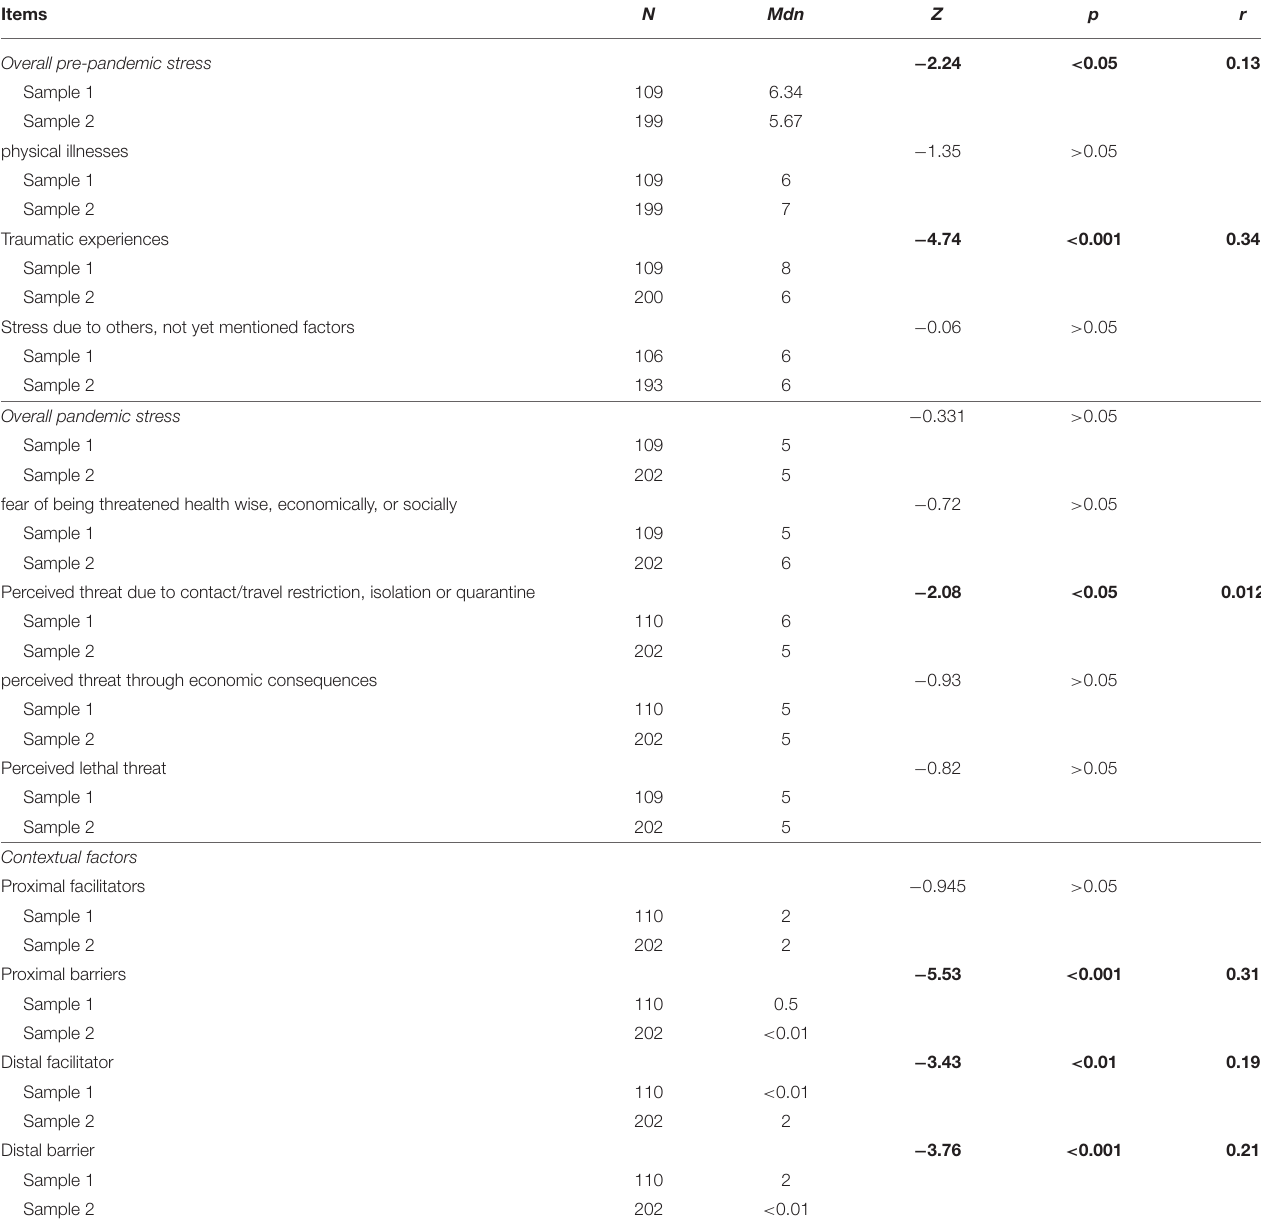
TABLE 4 | Descriptive sample comparison for the components of the stress barometer.